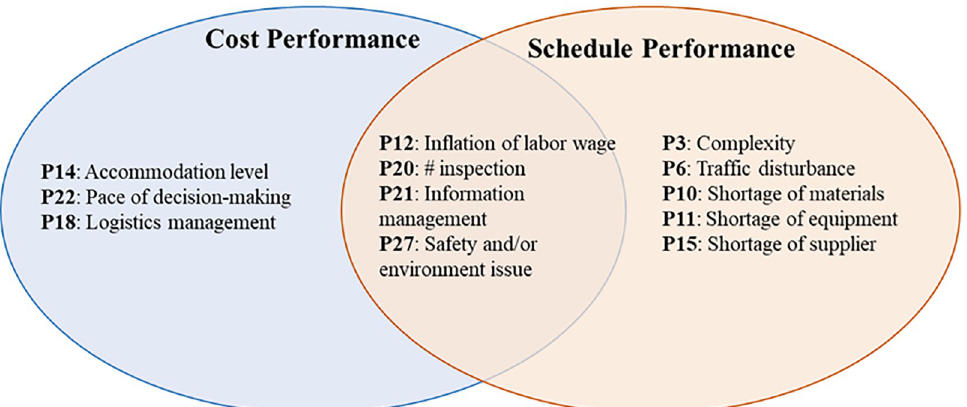
Fig 8. Comparative analysis of cost and schedule performance predictors.